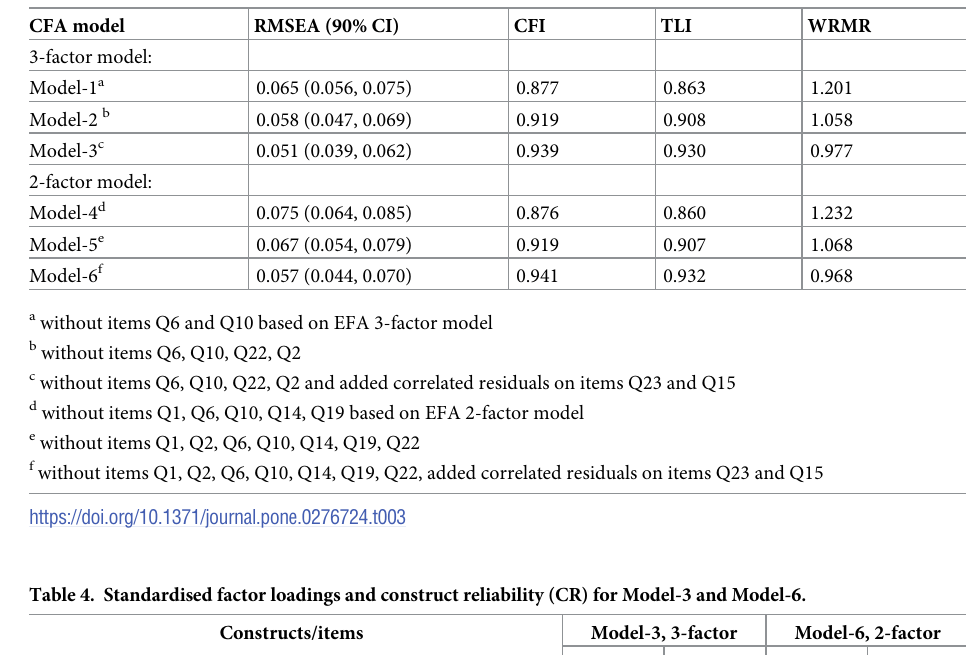
Table 3. Summary for M-ICU model fit indices (n = 229).